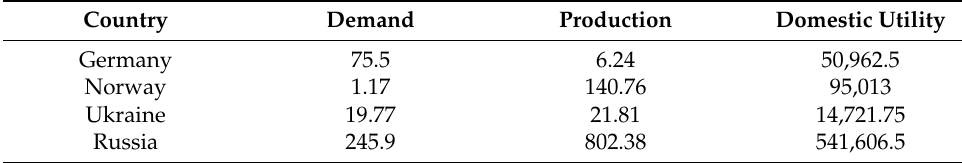
Table 3. Country-specific indicators and results for domestic utility